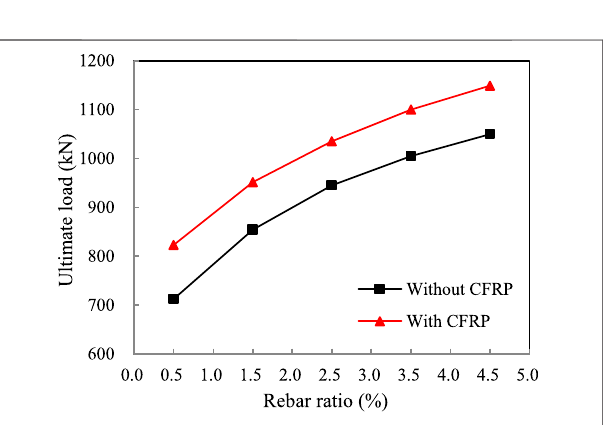
FIGURE 16 | Curve of the ultimate load varied with the longitudinal rebar